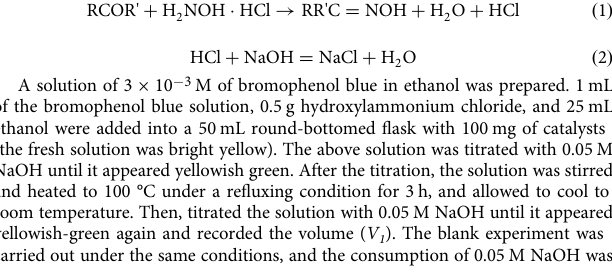
Fig. 21, Model 3: the C − F bonds are adjacent to C = O bonds, Model 4: the bonds of C − F and C = O are separated by three C − C bonds) for additional DFT calculations. The calculated projected density of states of the O 2 p orbitals in two model structures illuminated that the existence of fl uorine adjacent to C = O leads to the upshift of the p -band centre from − 4.29 in Model 4 to − 4.19 eV in Model 3, suggesting the C = O group become more active in catalyzing the ODH reactions when fl uorine is located at the adjacent carbon atom, which is consistent with the performance of ODH